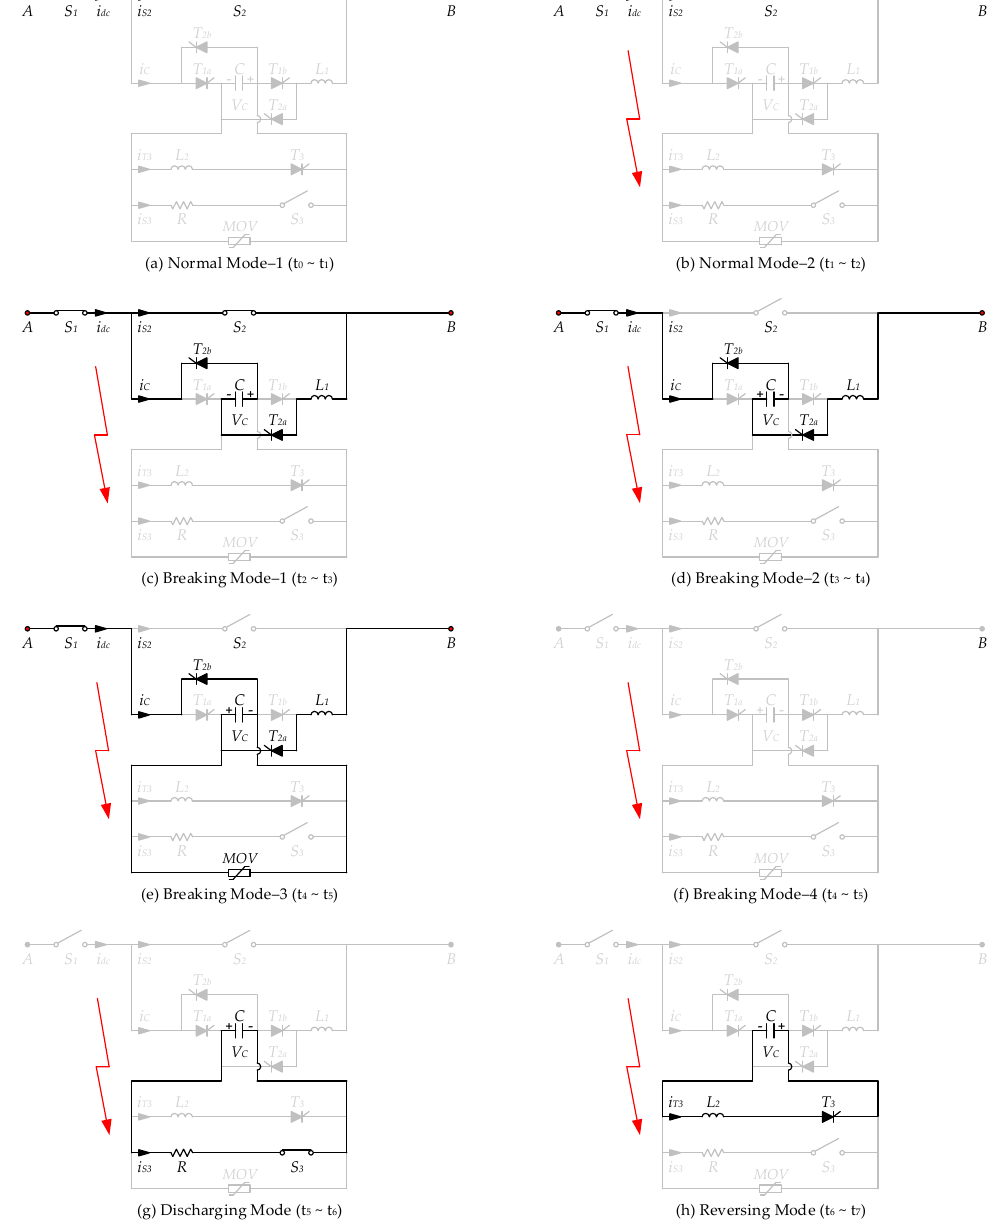
Figure 4. Operating modes of the proposed HCB topology with DC fault at the A-side.